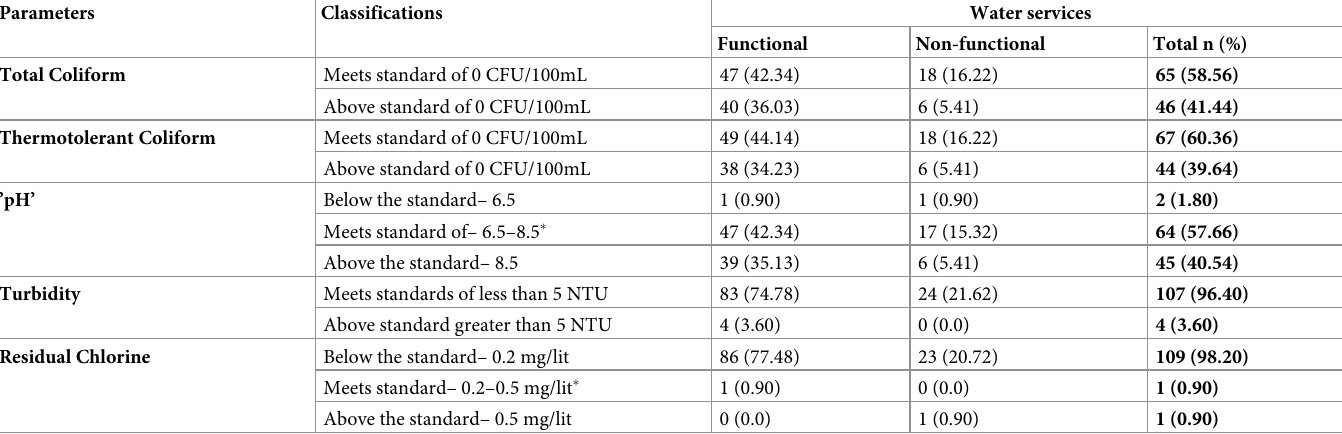
Table 5. Water quality parameters versus services functionality in Amhara and Afar